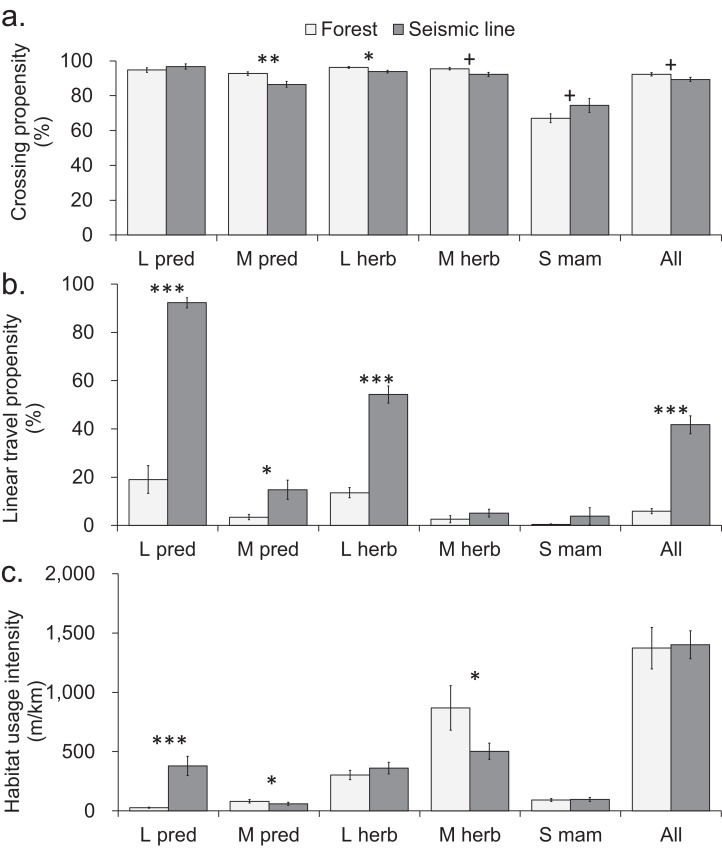
Comparison of mammal crosswise movement, linear movement and habitat use, between seismic line clearings and forest habitat for functional groups based on body size-diet combinations.Comparison of mammal movement and habitat use between seismic line (SL) clearings and forest transects for different body size-diet groups: large predator (L pred), mid-sized predator (M pred), large herbivore (L herb), mid-sized herbivore (M herb), small mammal (S mam). (A) Crossing propensity (% of transect approaches which fully crossed), (B) linear travel propensity (% of track length which was linear along the transect), (C) habitat usage intensity (total on transect track extent for multiple species recorded simultaneously). Values are means and standard errors (n = 14 paired transects in forest and SLs), with results declared significant by Benjamini-Hochberg (BH) procedure and paired t-test P-values (unadjusted, *P < 0.05, **P < 0.01, ***P < 0.001). Results declared non-significant by BH procedure and unadjusted P < 0.1 indicated by + (Tables S8–S10).